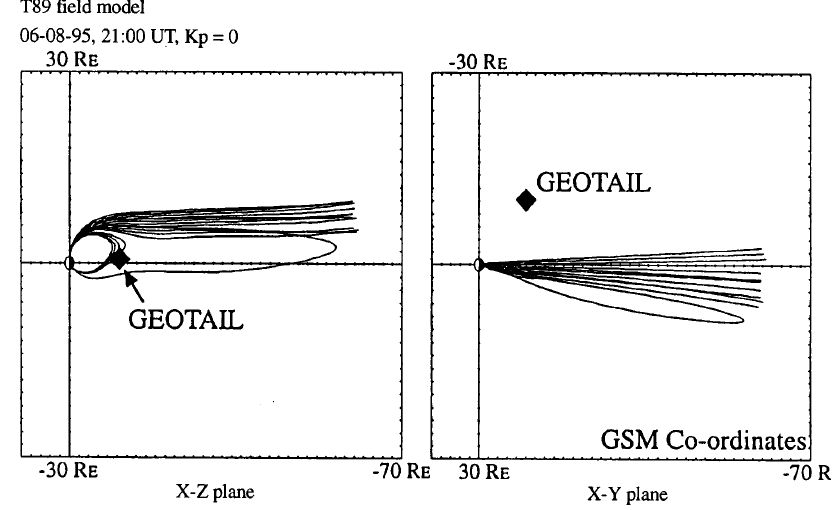
Fig. 2. Magnetic field line mapping in the GSM X-Z and X-Y planes, using T89, of the ionospheric area in the CUTLASS field of view covered by a typical equatorward flowburst at 21:10 UT (see text for details). The location of the Geotail spacecraft is